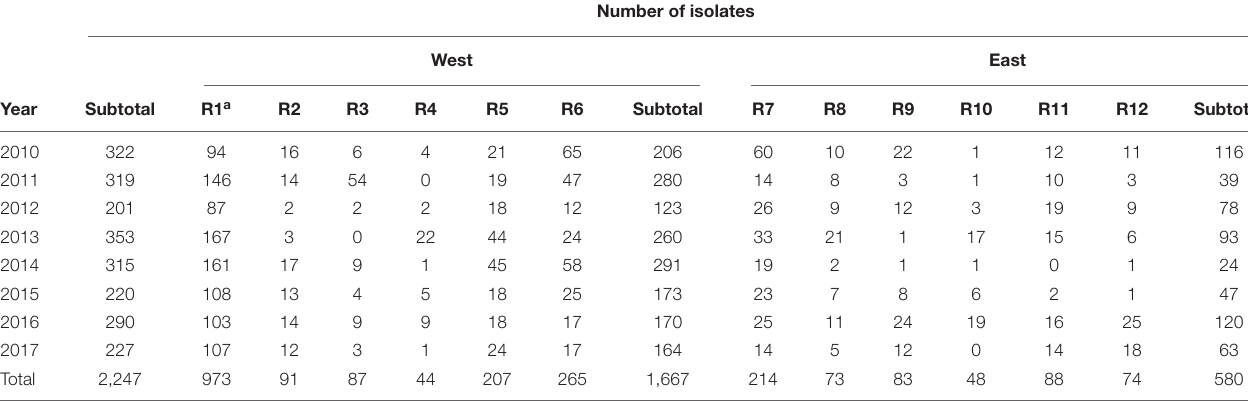
TABLE 1 | The numbers of Puccinia striiformis f. sp. tritici isolates obtained from 12 epidemiological regions in the United States from 2010 to 2017. Number of isolates West East